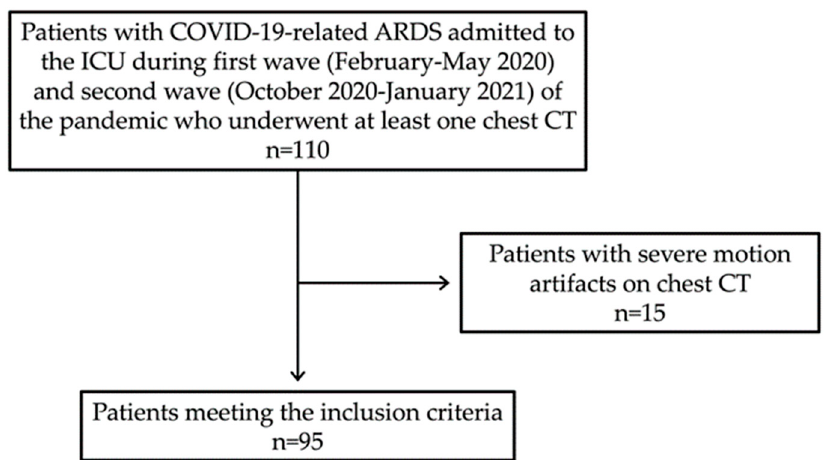
Figure 1. Flow diagram of patient selection in the